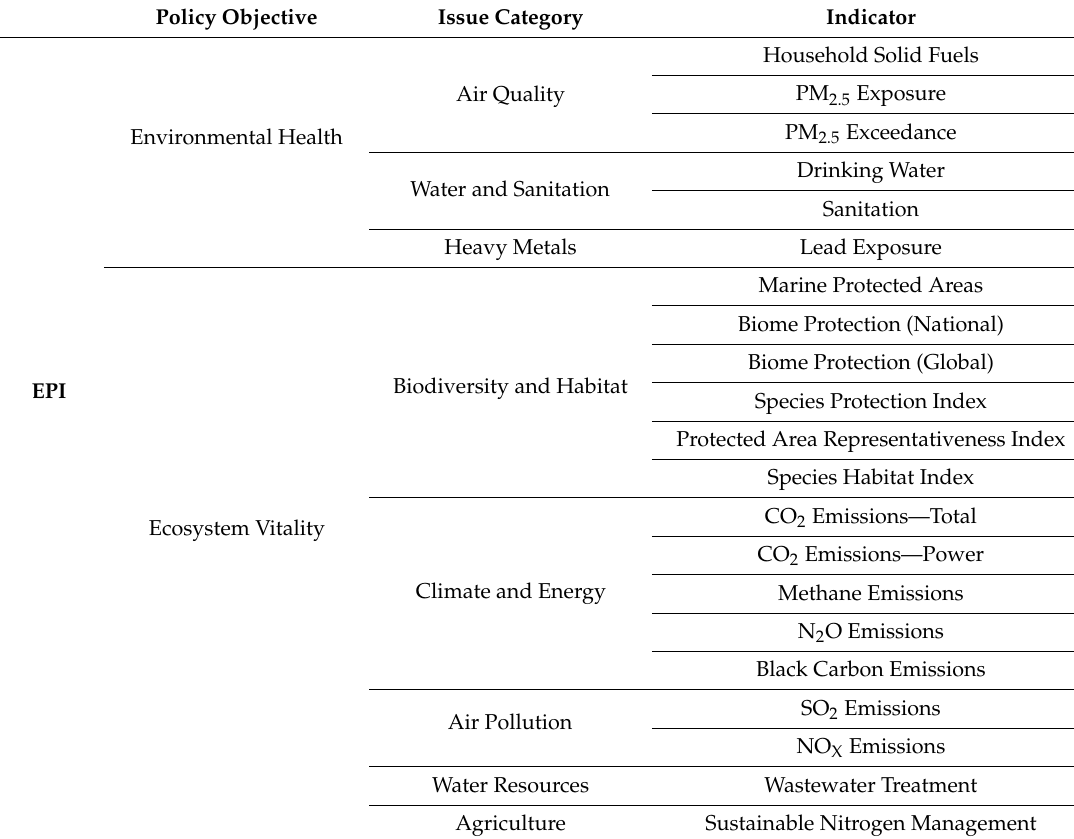
Table 1. Categorization of EPI